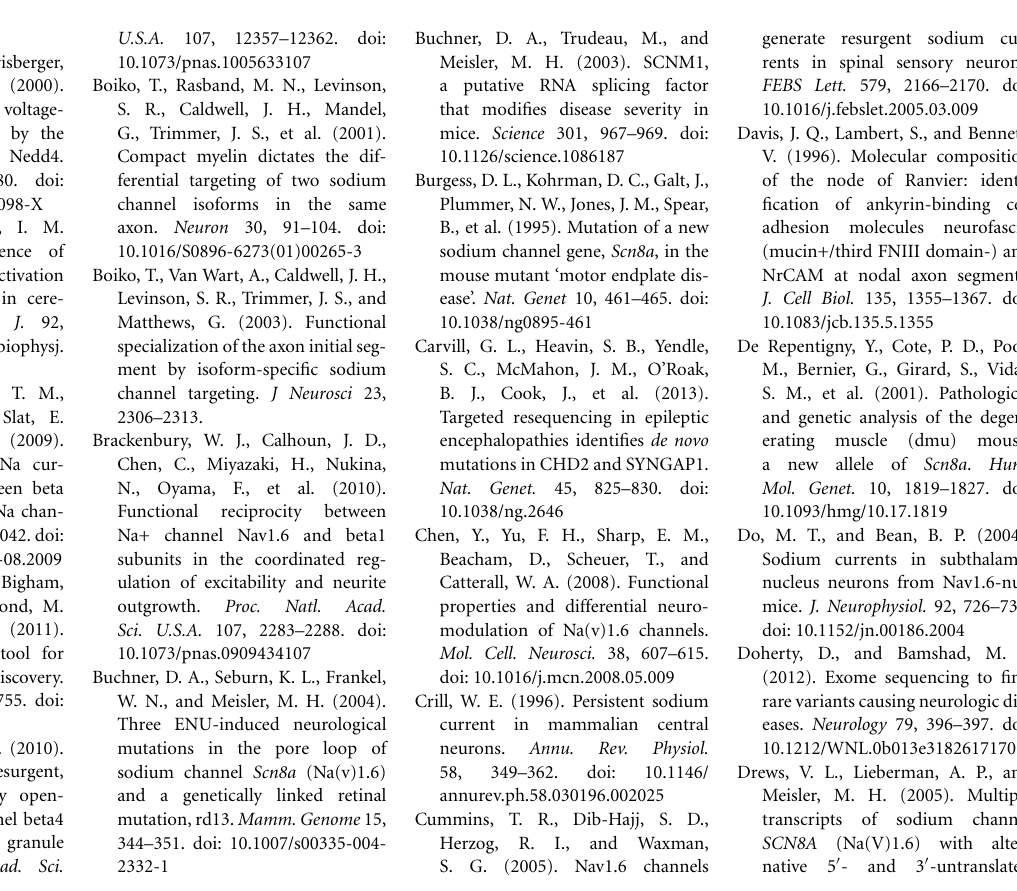
Figure S1 | Amino acid sequence of human and mouse SCN8A . The predicted human amino acid sequence corresponds to the predominant transcript in adult brain containing exon 5A and exon 18A and using the upstream splice donor site of exon 10B. The approximate locations of transmembrane segments S1–S6 of domains I–IV of the protein are underlined. Human coding sequence, GenBank AF050736; mouse coding sequence, GenBank AF049617. ∇ , exon borders; ∗ , protein kinase A consensus sequence; arrow, tyrosine kinase consensus; dots, amino acid identity. Adapted from Plummer et al.